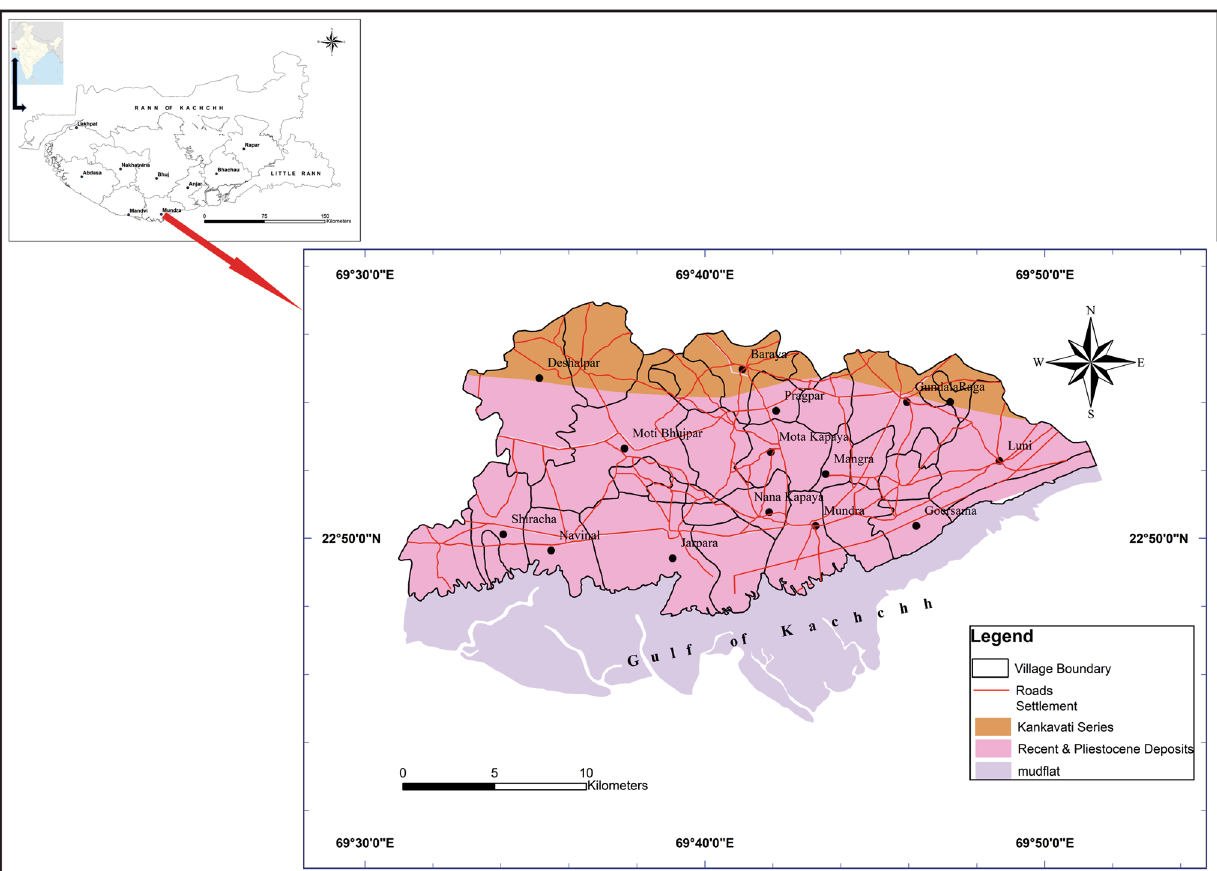
Fig. 1 Geological map of study area (modified after Biswas